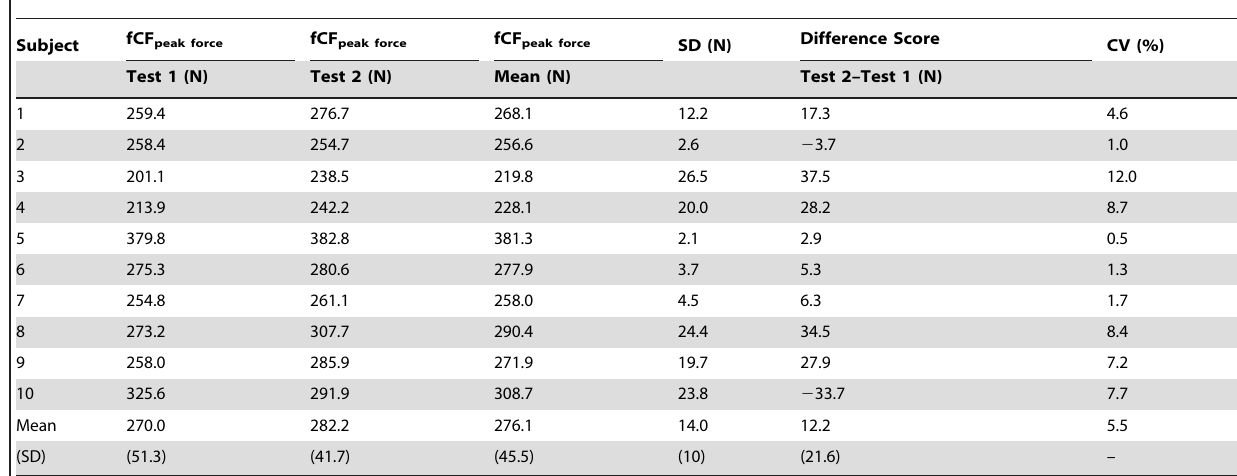
Table 1. Forearm critical intensity peak force (fCF peak force ) and its test-retest repeatability.